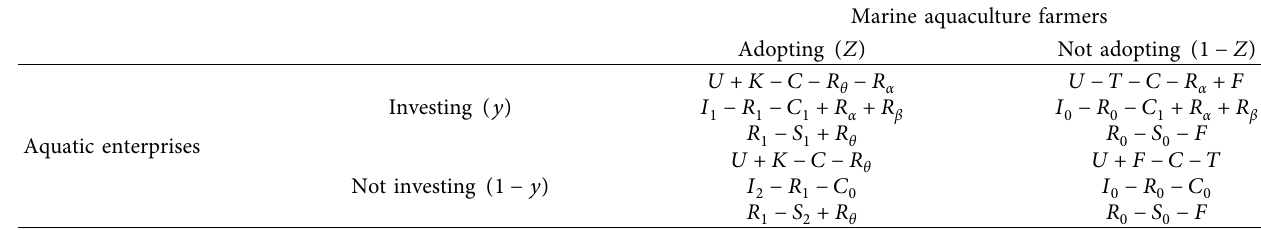
Table 1: Payment matrix of the tripartite evolutionary game with government participation.